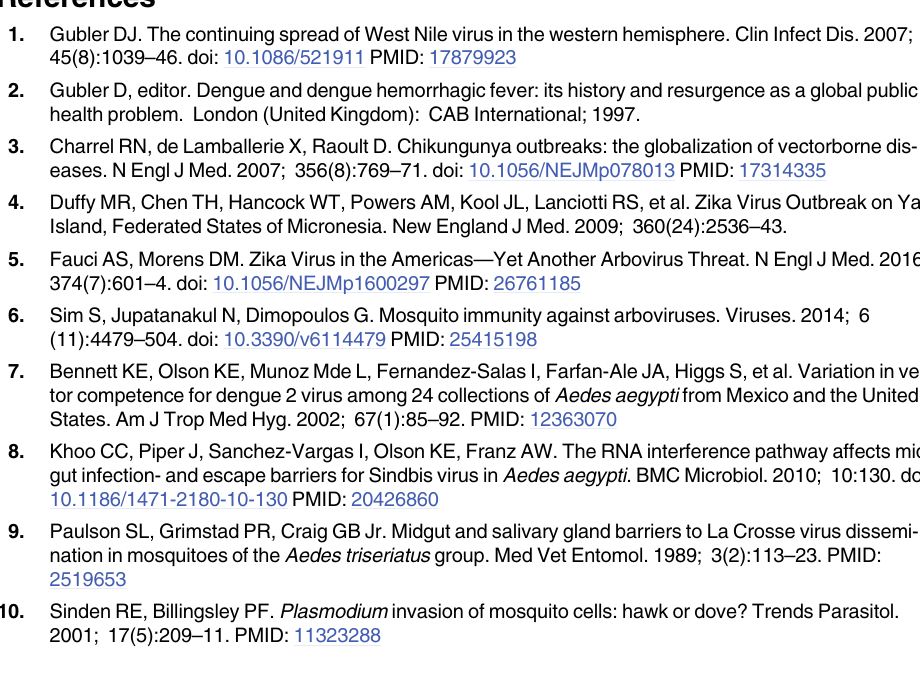
S1 Table. SIMPER analysis showing the major OTUs contributing to group differences.